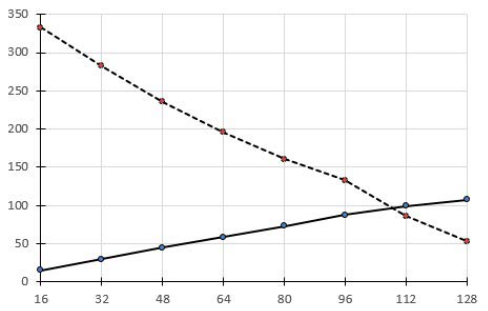
Figure 16. Number of requests in execution in the private (solid line) and public (dashed line) clouds vs. max number of VMs in the private cloud.